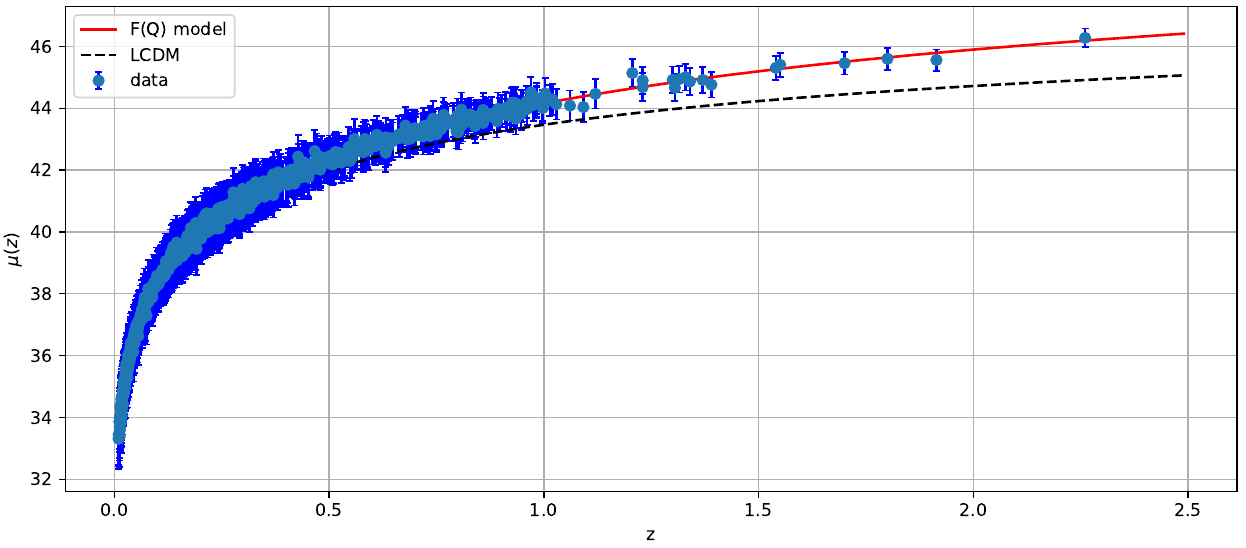
Figure 2. The error bar plot of µ ( z ) versus z for the considered f ( Q ) model. The solid red line is the curve for the f ( Q ) model, whereas the black dotted line represents the Λ CDM model. The blue dots depict the 1048 points of the Pantheon data.